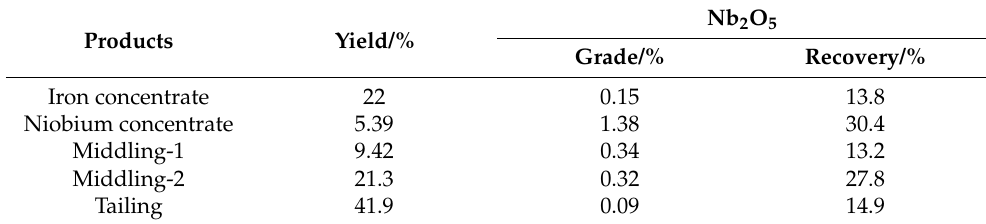
Table 7. Flotation optimization experimental results.